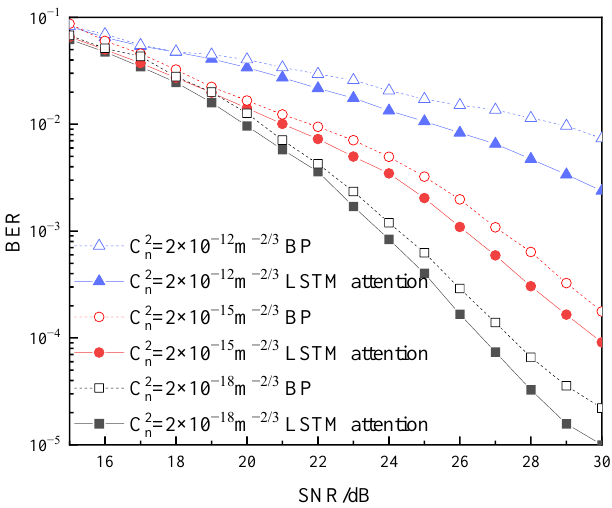
Figure 6. BER under different atmospheric turbulence channels.